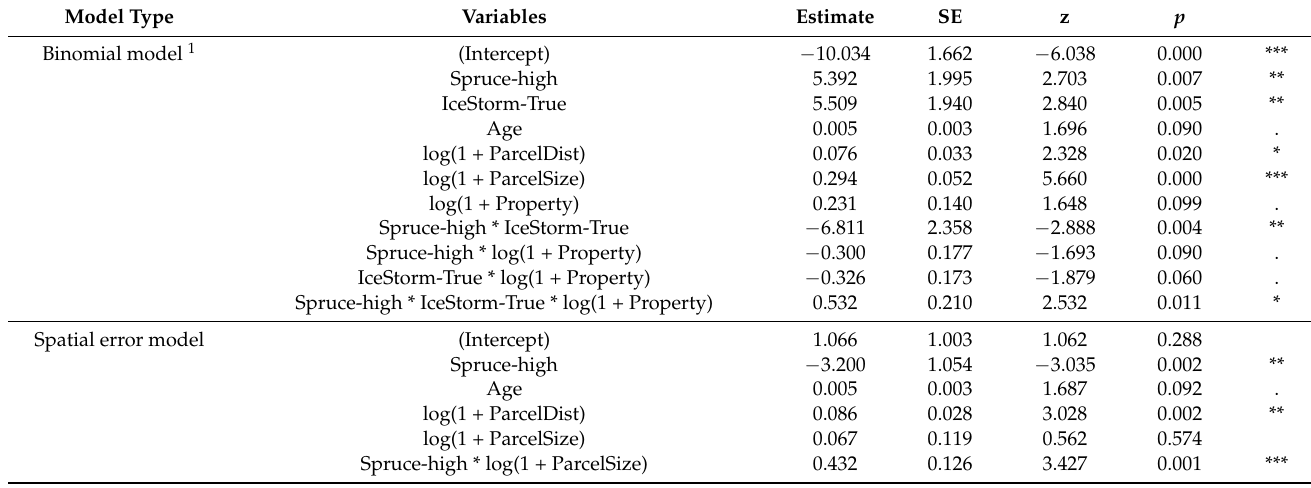
Table 2. Statistics of the binomial and spatial error models for sanitary felling. Variables, estimates, standard error, z value, and p values are shown. * p < 0.05, ** p < 0.01, *** p < 0.001, 1 Moran eigenvectors used in the model are not shown. Model Type